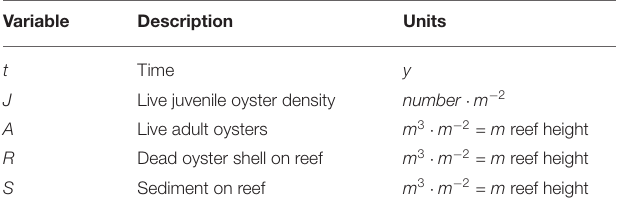
TABLE 1 | JARS model variables, description, and